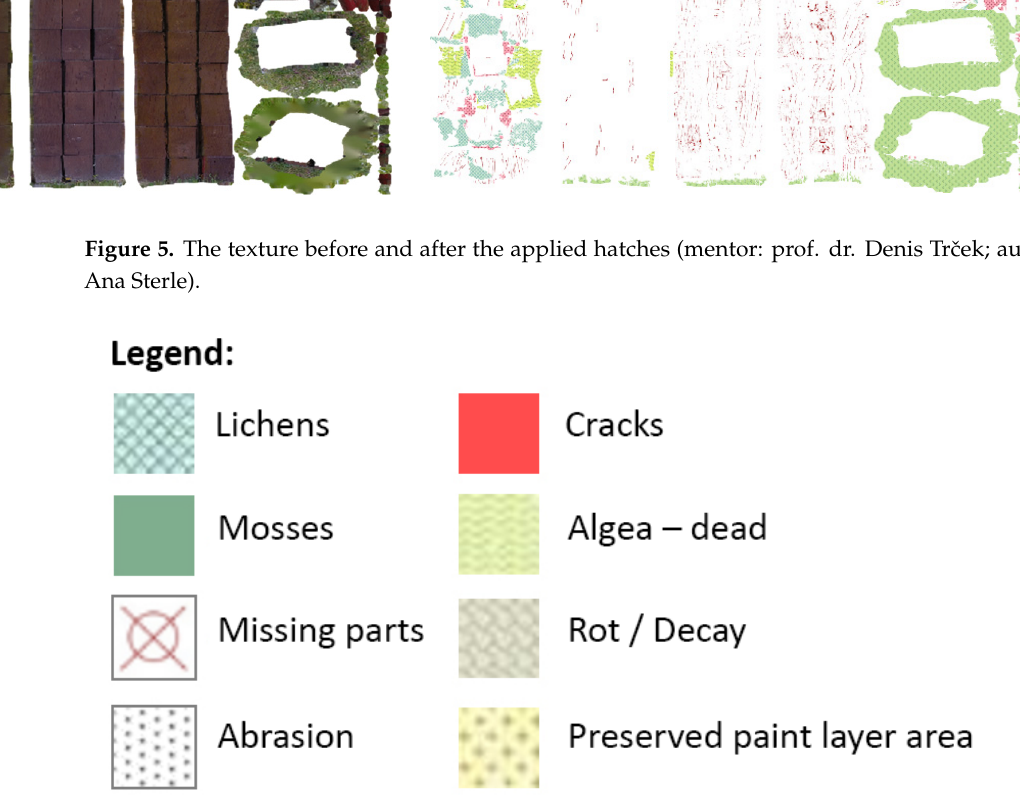
Figure 6. Legend of applied hatch patterns used on Figures 4 and 5 (mentor: Prof. Mag. Tamara Tr č ek Pe č ak; authors: Lara Skukan, Ana Sterle).